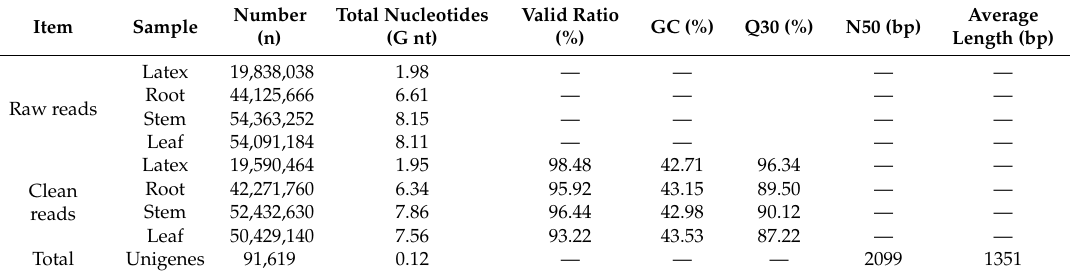
Table 1. Summary of sequencing and de novo assembling of the transcriptome of E. tirucalli